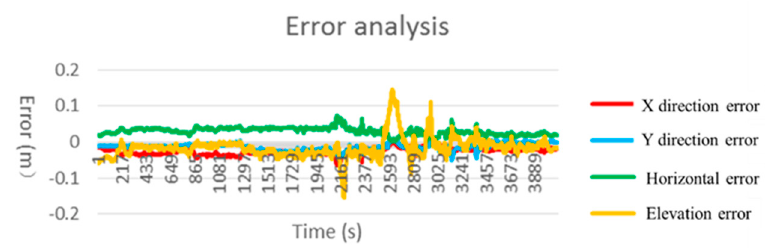
Figure 12. Error analysis chart.